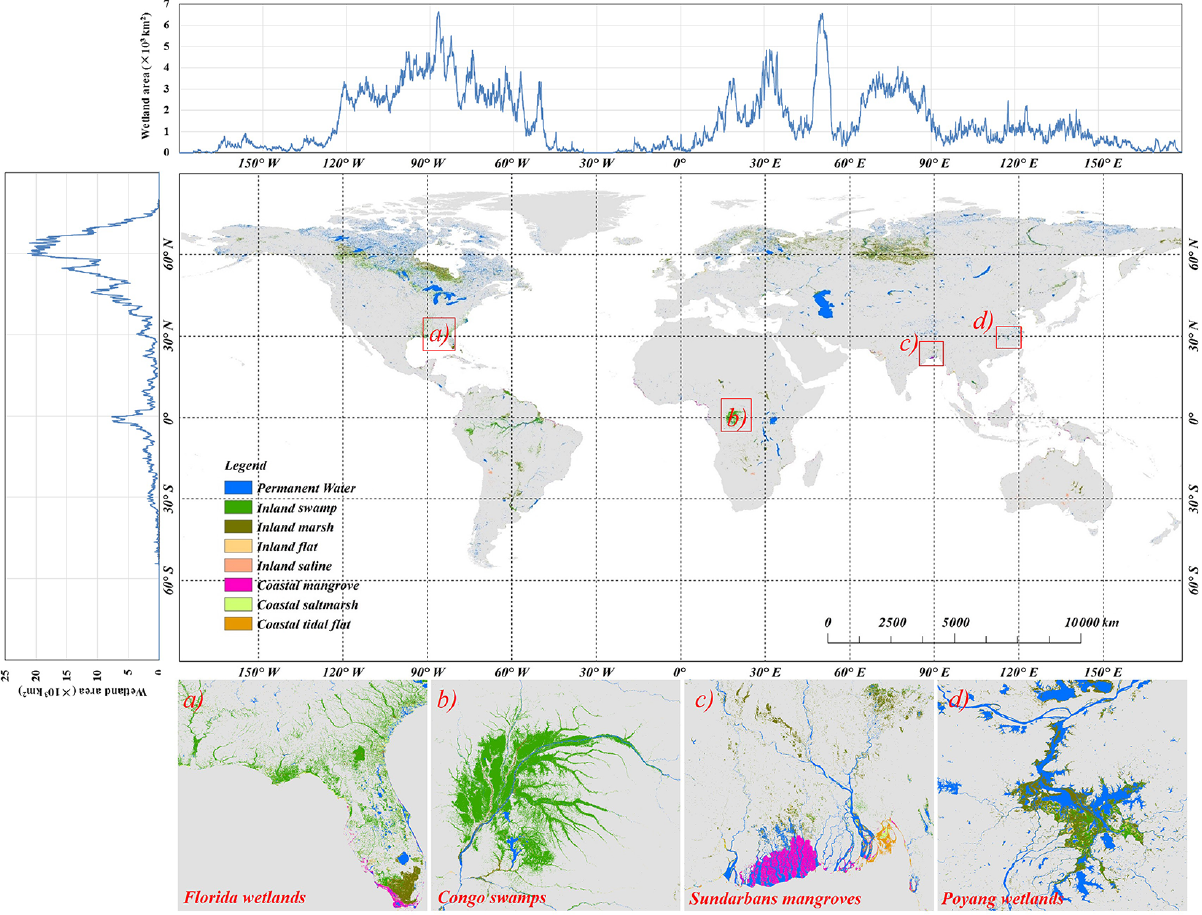
Figure 9. The overview of global 30m fine wetland maps and their area statistics in latitudinal and longitudinal directions in 2020. Four